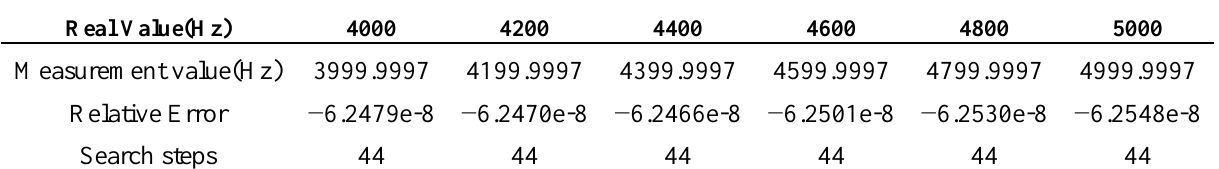
Table 2. Measurement errors and search steps for different resonant frequencies using the search method.